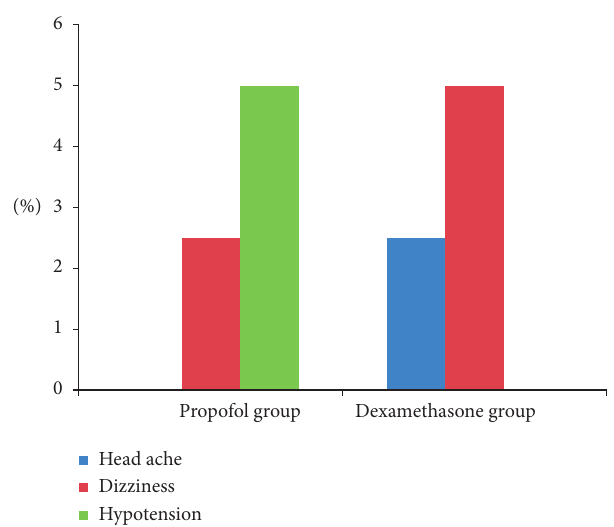
Figure 4: Associated side effects observed within 24 hours after taking